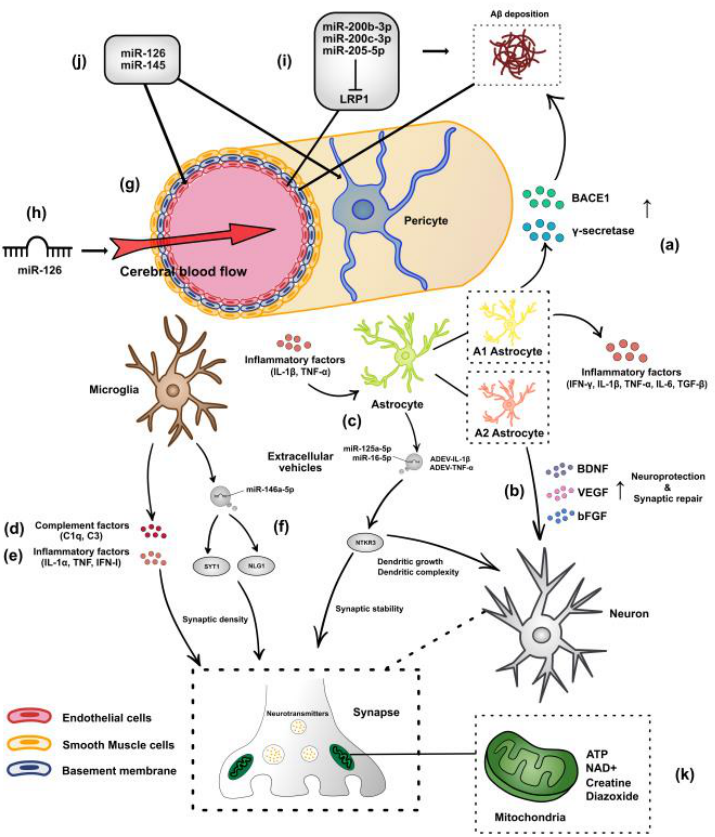
Figure 1. Interconnection of synapses and the cerebrovascular system. ( a ) A1 astrocytes cause a high production of A β by producing inflammatory factors, including IFN γ , IL-1 β , TNF- α , IL-6, TGF- β , and massive amyloid precursor protein-cleaving enzymes, such as β -secretase (BACE1) and γ -secretase. ( b ) A2 astrocytes release neurotrophic factors, such BDNF, VEGF, and bFGF, which contribute to synaptic repair and neuroprotection. ( c ) Astrocytes secrete inflammatory factors, such as IL-1 β and TNF α , to stimulate the production of ADEVs, carrying miR-125a-p and miR-16-5p to target NTKR3 to regulate synaptic stability. ( d ) Microglia alter the synaptic phenotypes in the hippocampal neuron by releasing a series of complement factors (e.g., C1q and C3), ( e ) inflammatory factors (e.g., IL-1 α , TNF, and type-I IFN), and ( f ) extracellular vesicles (EVs) to deliver miR-146a-5p to target SYT1 and NLG1 to regulate synaptic density. ( g ) The cerebrovascular system is composed of endothelial cells, smooth muscle cells (SMCs), pericytes, perivascular immune cells (e.g., microglia), and surrounding astrocytes. Abnormal cerebral blood flow leads to a greater tendency for A β to be deposited within the basement membrane of blood vessels. ( h ) miR-126 in the endothelial cells participate in the regulation of cerebral blood flow. ( i ) miR-200b-3p, miR-200c-3p, and miR-205-5p considerably reduced low-density LRP1 in microvascular endothelial cells impairing A β clearance. ( j ) miR-126 and miR-145, specifically in brain capillaries, elevate pericyte coverage as well as promote endothelial cell activation. ( k ) Providing neurons with mitochondria-related energy chemicals, such as adenosine triphosphate (ATP), nicotinamide adenine dinucleotide (NAD+), creatine, or diazoxide are efficacious treatments that can effectively protect neurons from metabolic and A β -toxicity